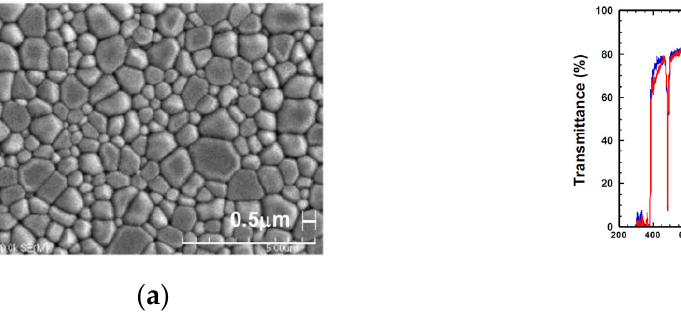
Figure 5. Microstructure of TGG transparent nano-ceramic and its transmittance spectra [39]; ( a ) SEM image showing the microstructure of a typical TGG transparent nano-ceramics sample; ( b ) Comparison of transmission spectra between TGG nano-ceramics samples and TGG single crystal. Reprinted with permission from Ref. [39]. Copyright 2011, copyright IEEE Xplore.